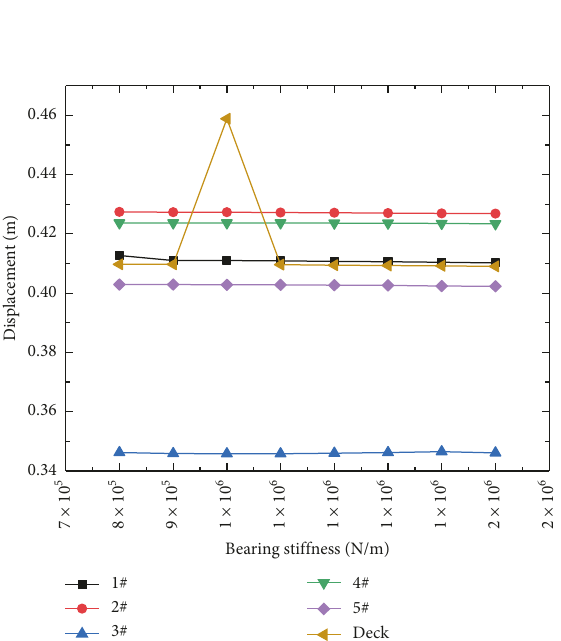
Figure 9: Displacement of top pier and deck.